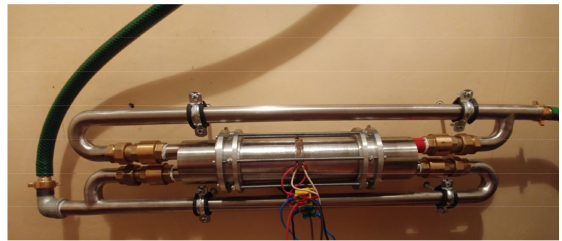
Figure 16. Motor–pump prototype.